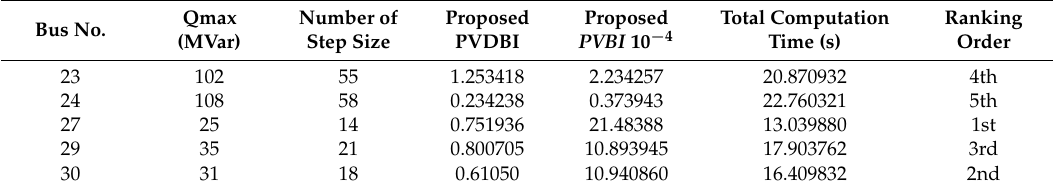
Table 6. Results of the proposed PVBI of the IEEE 30-bus power system.